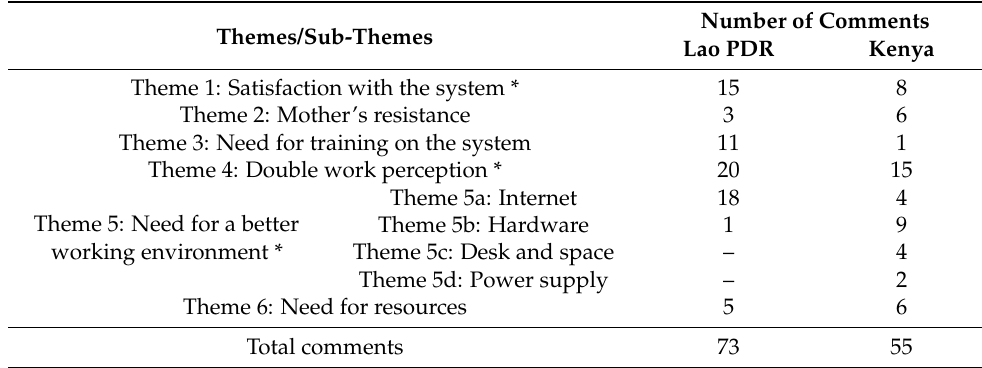
Table 2. Summary of comments for themes and